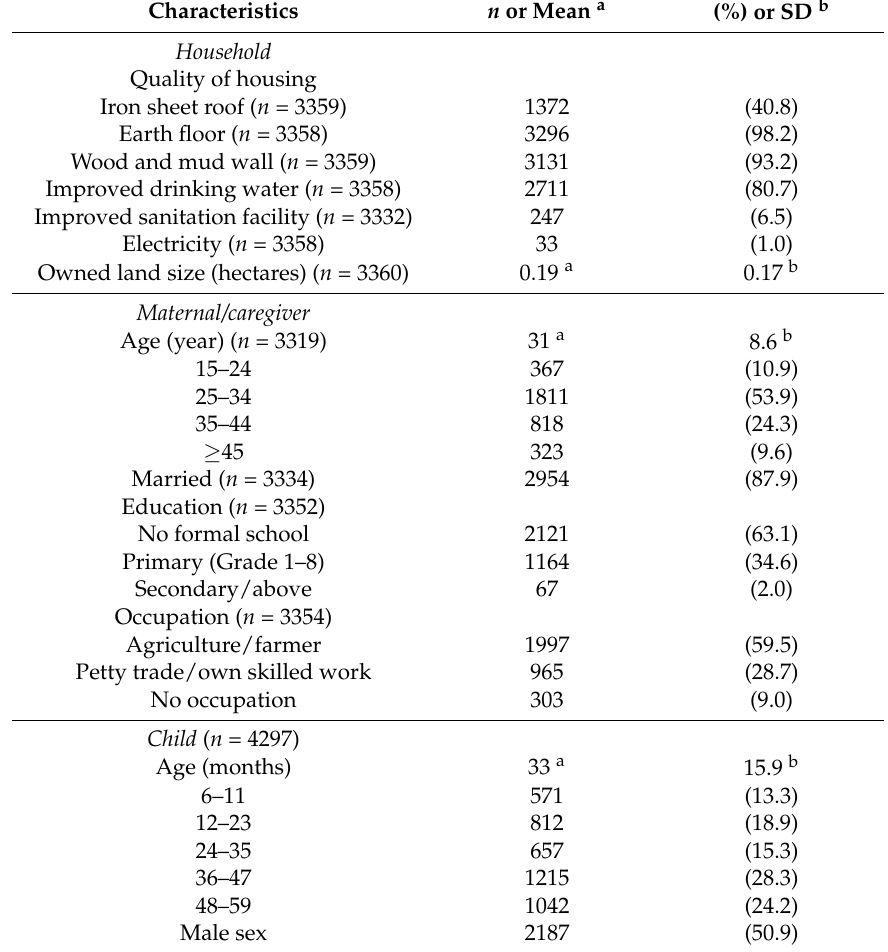
Table 1. Household, maternal/caregiver and child characteristics of participants in rural south